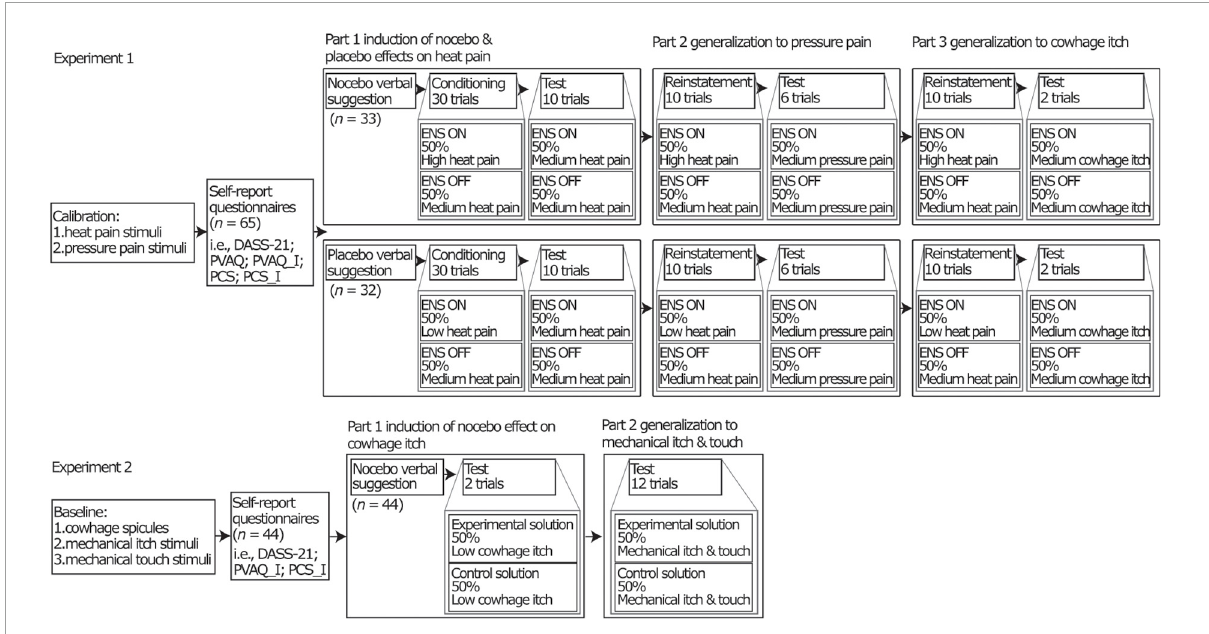
FIGURE1 Overview of the full design of the two separate experiments. For experiment 1, “ENS” was functioned as a placebo treatment. “ON” and “OFF” indicated the sham (de)activation of the ENS device. “ON” represents an experimental trial and “OFF” represents a control trial. The ENS device was a transcutaneous electrical nerve stimulation (TENS) device (model EM80, Beurer, Germany). Participants rated their pain intensities on a 0 (no pain at all)-10 (worst pain imaginable) numerical rating scale (NRS). Low (NRS 0.5-2), moderate (NRS 3-4.5), and high (NRS 5.5-7) heat pain intensities were individually calibrated. Moderate pressure pain intensity (NRS 3-4.5) was individually determined. For experiment 2, “experimental solution” was served as a nocebo treatment. “Experiment solution” represents an experiment trial and “control solution” represents a control trial. Throughout both experiments, participants received all stimuli in half of experimental trials and in half of control trials in all phases. DASS-21, The 21-item version of the Depression Anxiety Stress Scale; PVAQ, The Pain Vigilance and Awareness Questionnaire; PCS, The Pain Catastrophizing Scale; PVAQ-I, itch-adjusted version of the PVAQ; PCS-I, itch-adjusted version of the PCS. For more details of the design for two experiments see (4,